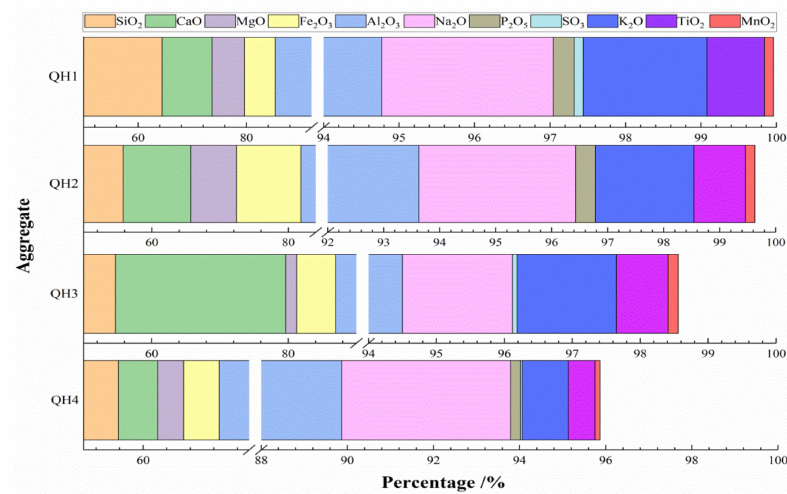
Figure 3. Chemical compositions of the four types of